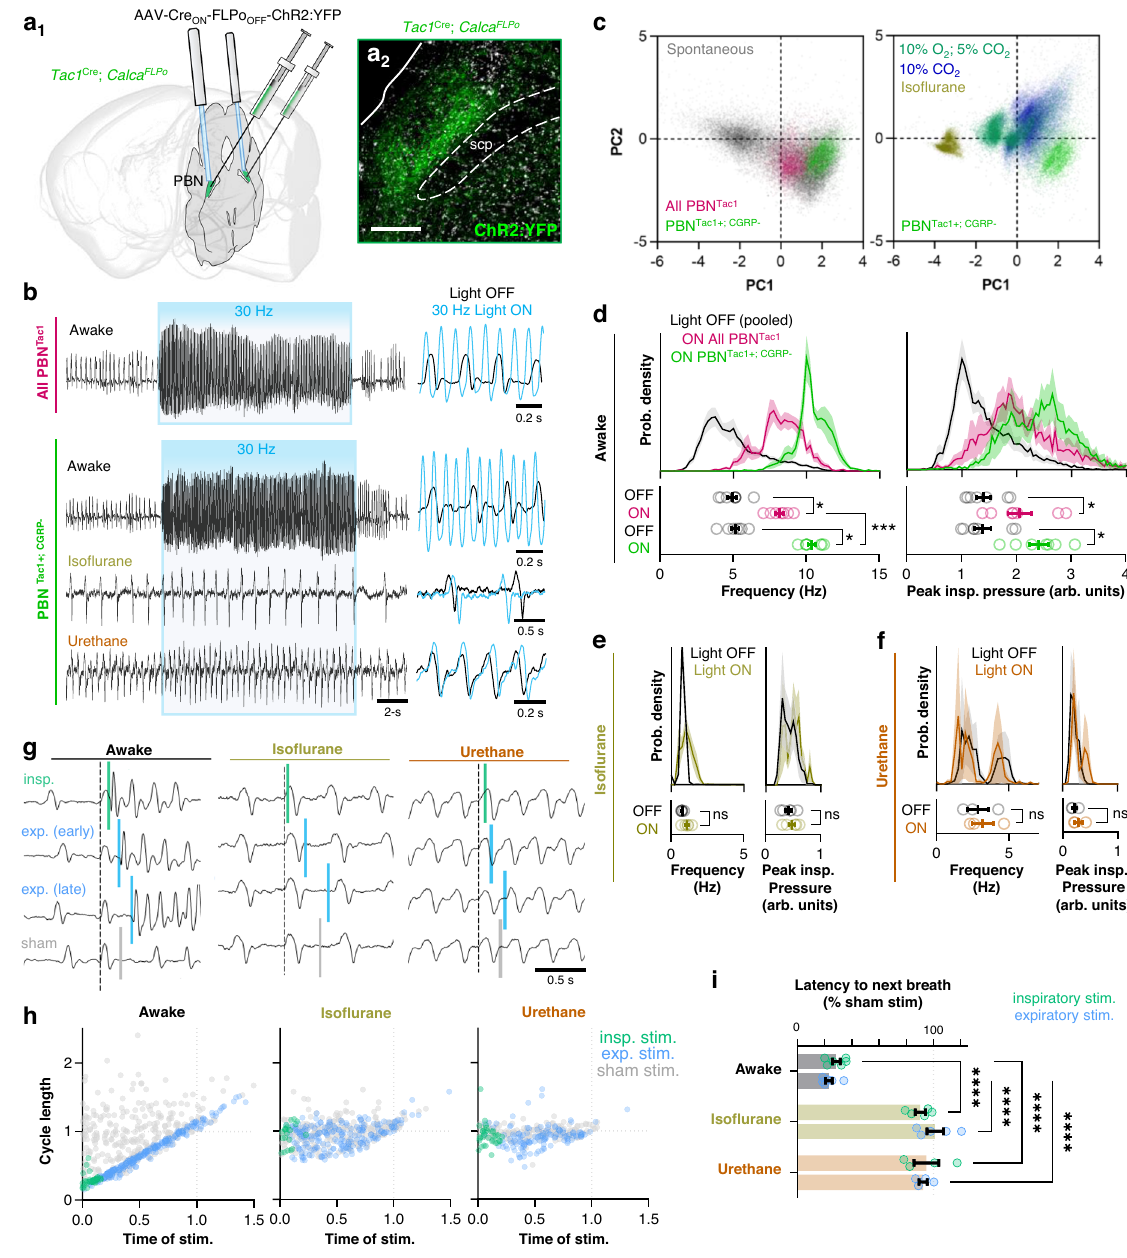
Fig. 3 | PBN neurons that express Tac1 but not CGRP exert potent control of breathing that is state-dependent and respiratory phase-independent. a Dual recombinase-dependent gene transfer approach to direct ChR2:YFP to neurons thatexpressTac1butnotCGRP(a 1 )andrepresentativehistologyofviralexpression (a 2 )in n =7mice.Scalebar=200 µ m. b Plethymographyrecordingscomparing30- Hz photostimulations (15s) when all Tac1 neurons are targeted versus targeting of Tac1 neurons that do not co-express CGRP. Photostimulations were repeated fol- lowing induction of iso fl urane or urethane anesthesia. Overlays of breathing pat- terns during 1s of light OFF (black) and light ON (blue) conditions shown on right. c PCA comparing spontaneous breathing patterns (22,351 breaths, n =6 mice) to breathingpatternsduringphotoactivationofPBN Tac1 (3,507breaths, n =7mice)and PBN Tac1+;CGRP- (3755 breaths, n =7 mice) neurons. d Probability-densities (top) and mean values from each mouse (bottom; n =7 Tac1, n =7 Tac1+; CGRP-) comparing breathing frequencies (left) and peak inspiratory pressures (right) during photo- stimulations. Tac1 and Tac1+; CGRP- data were pooled for the light OFF condition